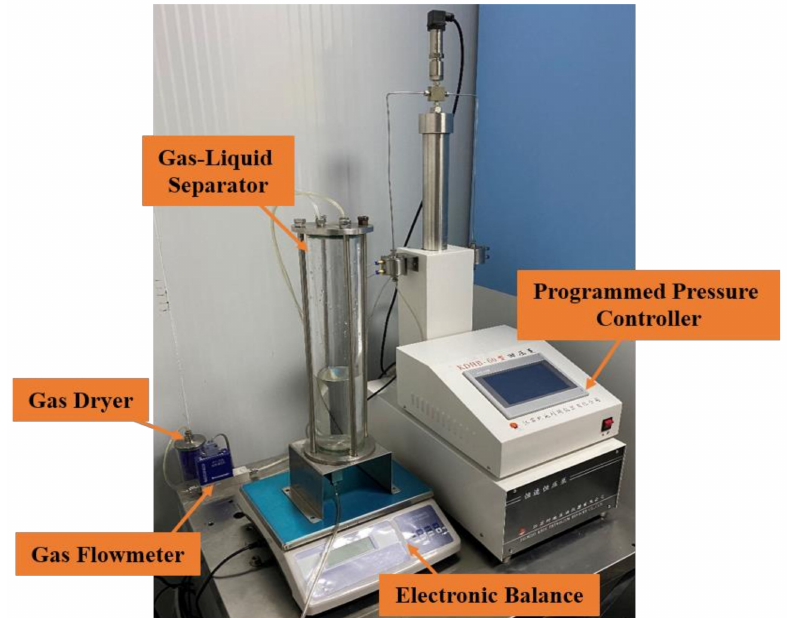
Figure 7. Schematic diagram of gas-liquid collection system.